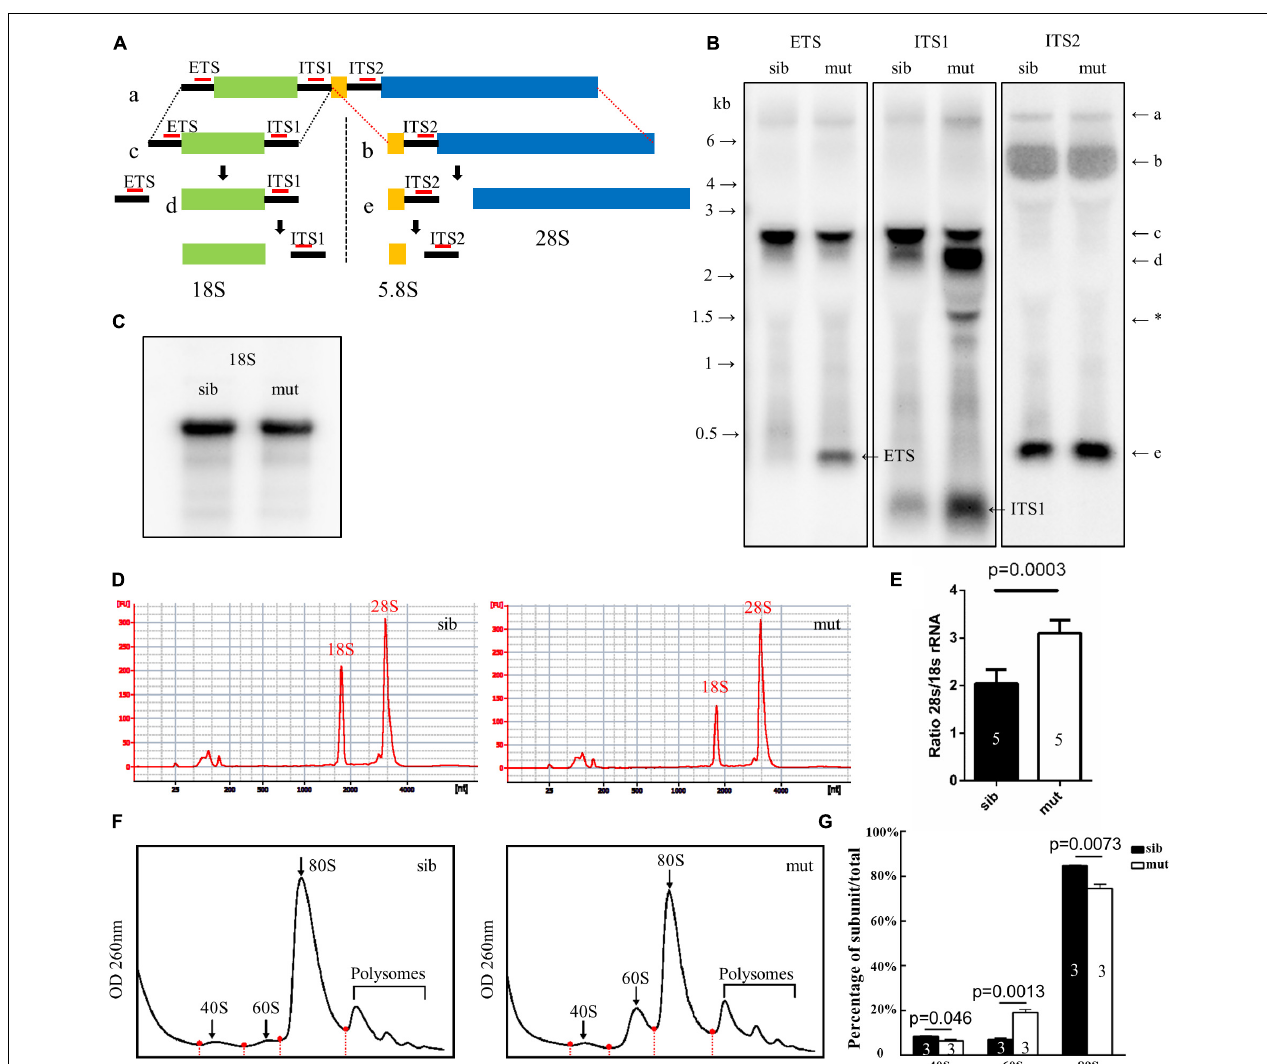
FIGURE 6 | Defects in 18S rRNA processing in ltv1 ∆ 14 /∆ 14 mutant. (A) Schematic diagram showing the processing pathway of 28S, 18S, and 5.8S rRNAs. The hybridization sites of each probe are indicated by red bars, respectively. (B,C) Northern blot analysis using the corresponding probes as indicated to detect 18S rRNA or the intermediate products of rRNA processing. Asterisk: unidentified rRNA intermediate product. (D) Representative analysis result by E-bioanalyzer. (E) The ratio of 28S/18S rRNA is increased in ltv1 ∆ 14 /∆ 14 mutants ( N = 5), as compared with siblings ( N = 5). Bars represent means with SD. ETS, external transcribed spacer; ITS, internal transcribed spacer. (F) Representative ribosome fractionation results of siblings and ltv1 ∆ 14 /∆ 14 mutants at 4 dpf. The peaks of 40S, 60S, and 80S are indicated by arrows. Red dots on the curves represent the lowest points flanking the peaks. The area under respective peaks of 40S, 60S, and 80S, circled by curves, dashed lines, and baselines are measured. (G) Percentages of 40S, 60S, and 80S in total lysate in siblings and ltv1 ∆ 14 /∆ 14 mutants at 4 dpf. Bars represent means with SD. Quantifications of three independent experiments are